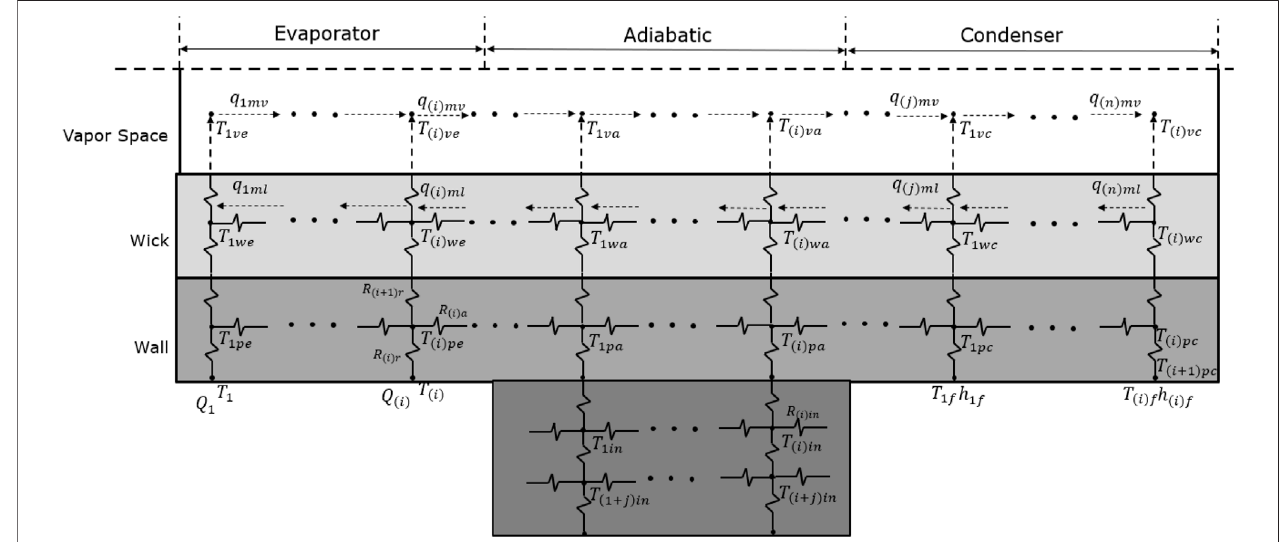
FIGURE 3 | Schematic diagram of the improved heat pipe model.